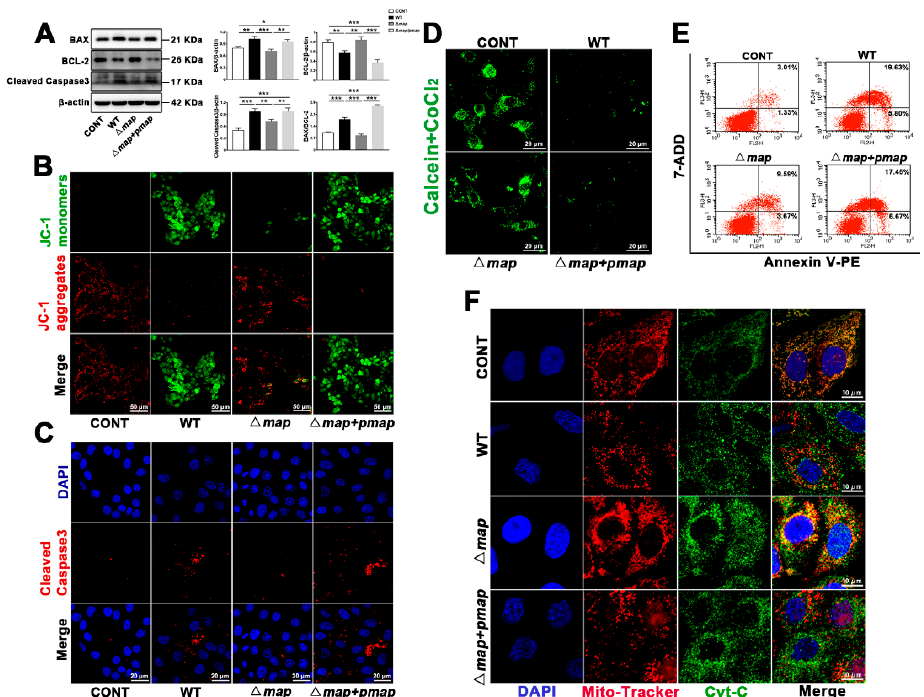
Figure 5. E. coli (EPEC)-Map results in sustained mPTP opening, Cyt-C release, low MMP, and apop- tosis. ( A ) The BAX, BCL-2, and cleaved caspase-3 levels were analyzed by Western blot. ( B ) JC-1